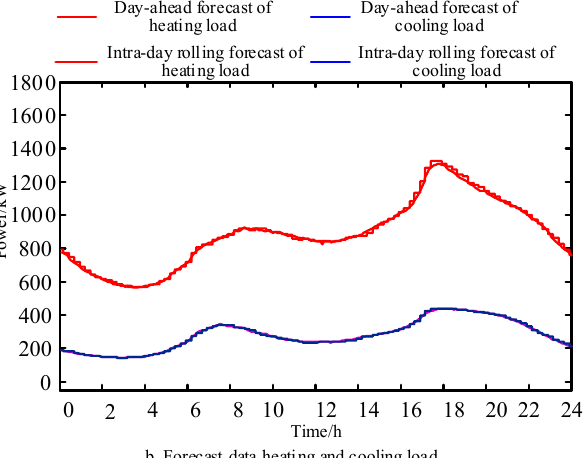
Figure A2. The day-ahead and intra-day forecast curves of PV and load output of the energy station 3.